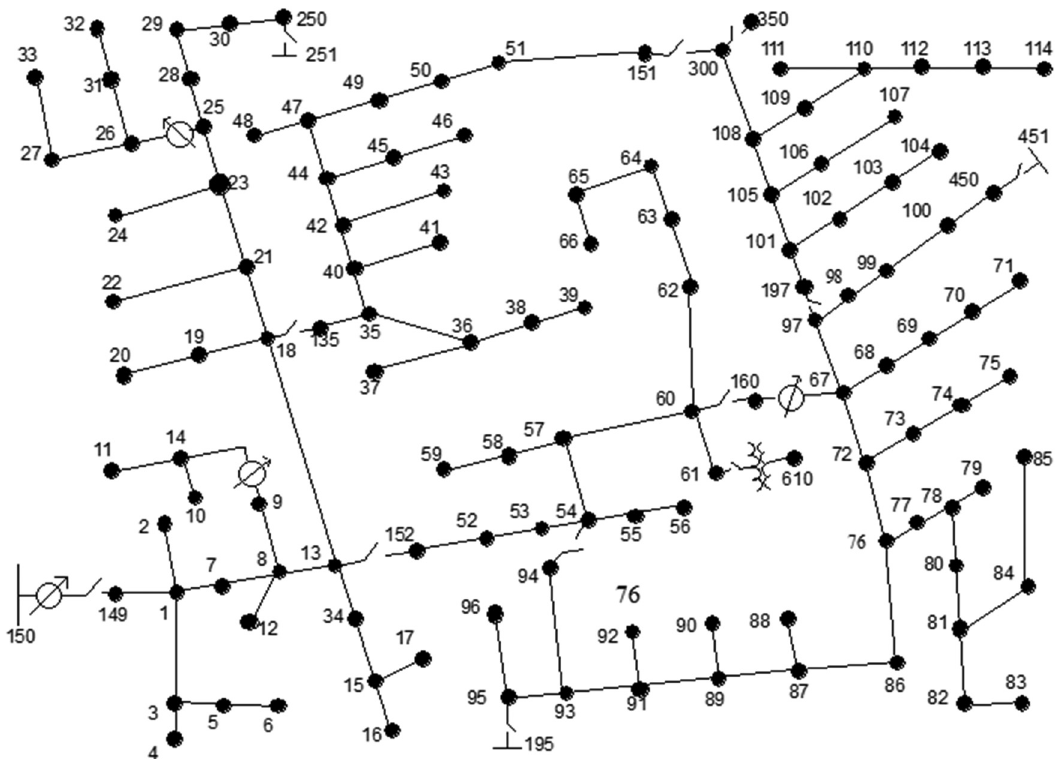
Figure 6: IEEE 123 - bus node map [ 18,32 ]